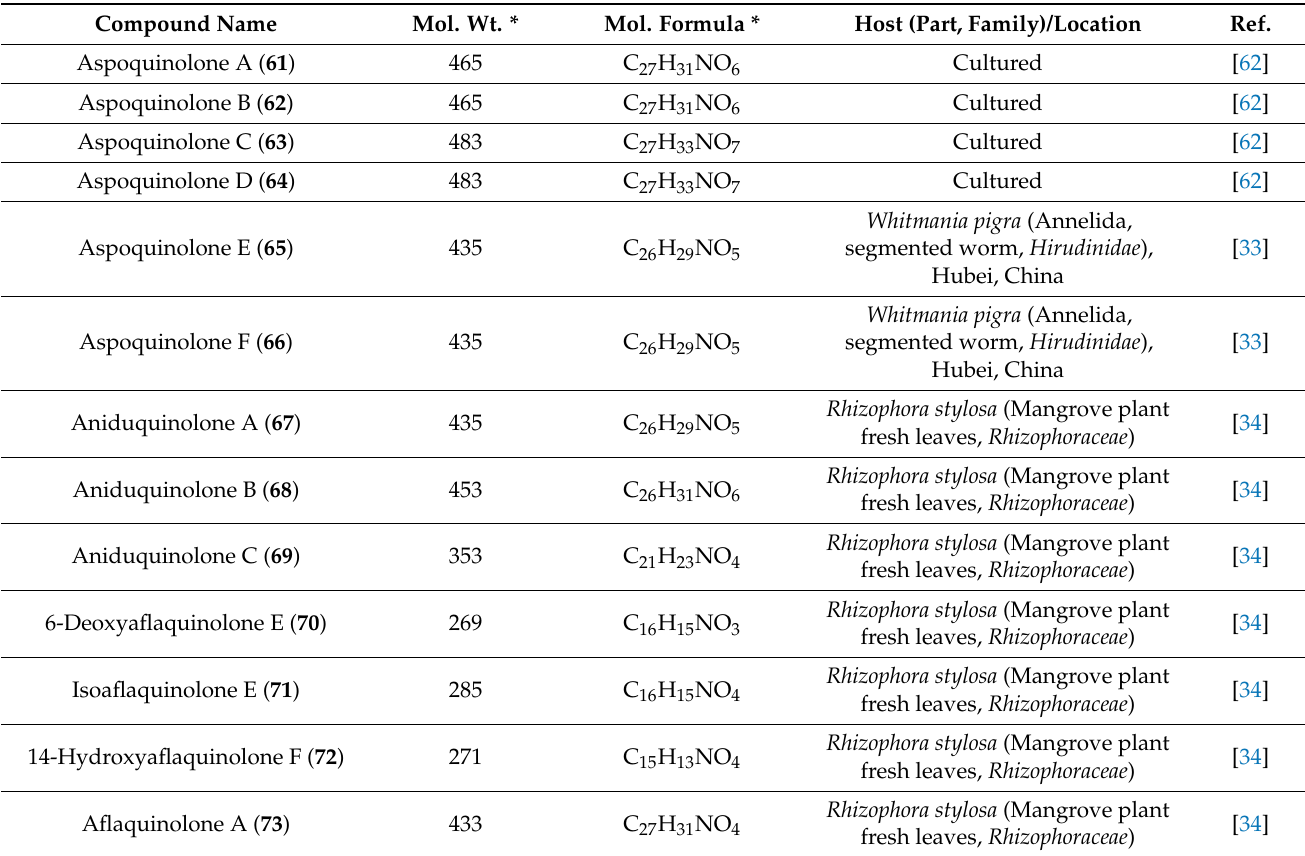
Table 5. Quinoline alkaloids reported from Aspergillus nidulans .